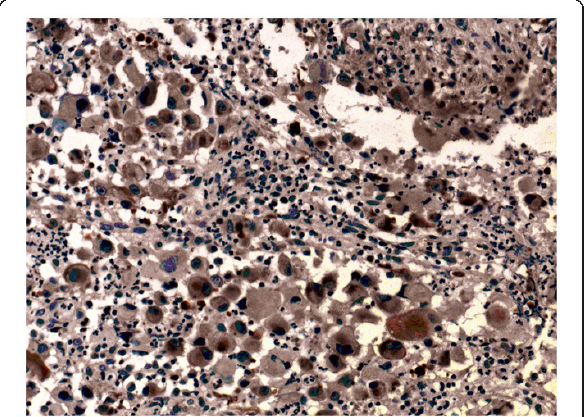
Figure 1 Hematoxylin-eosin staining of LCS (100×).